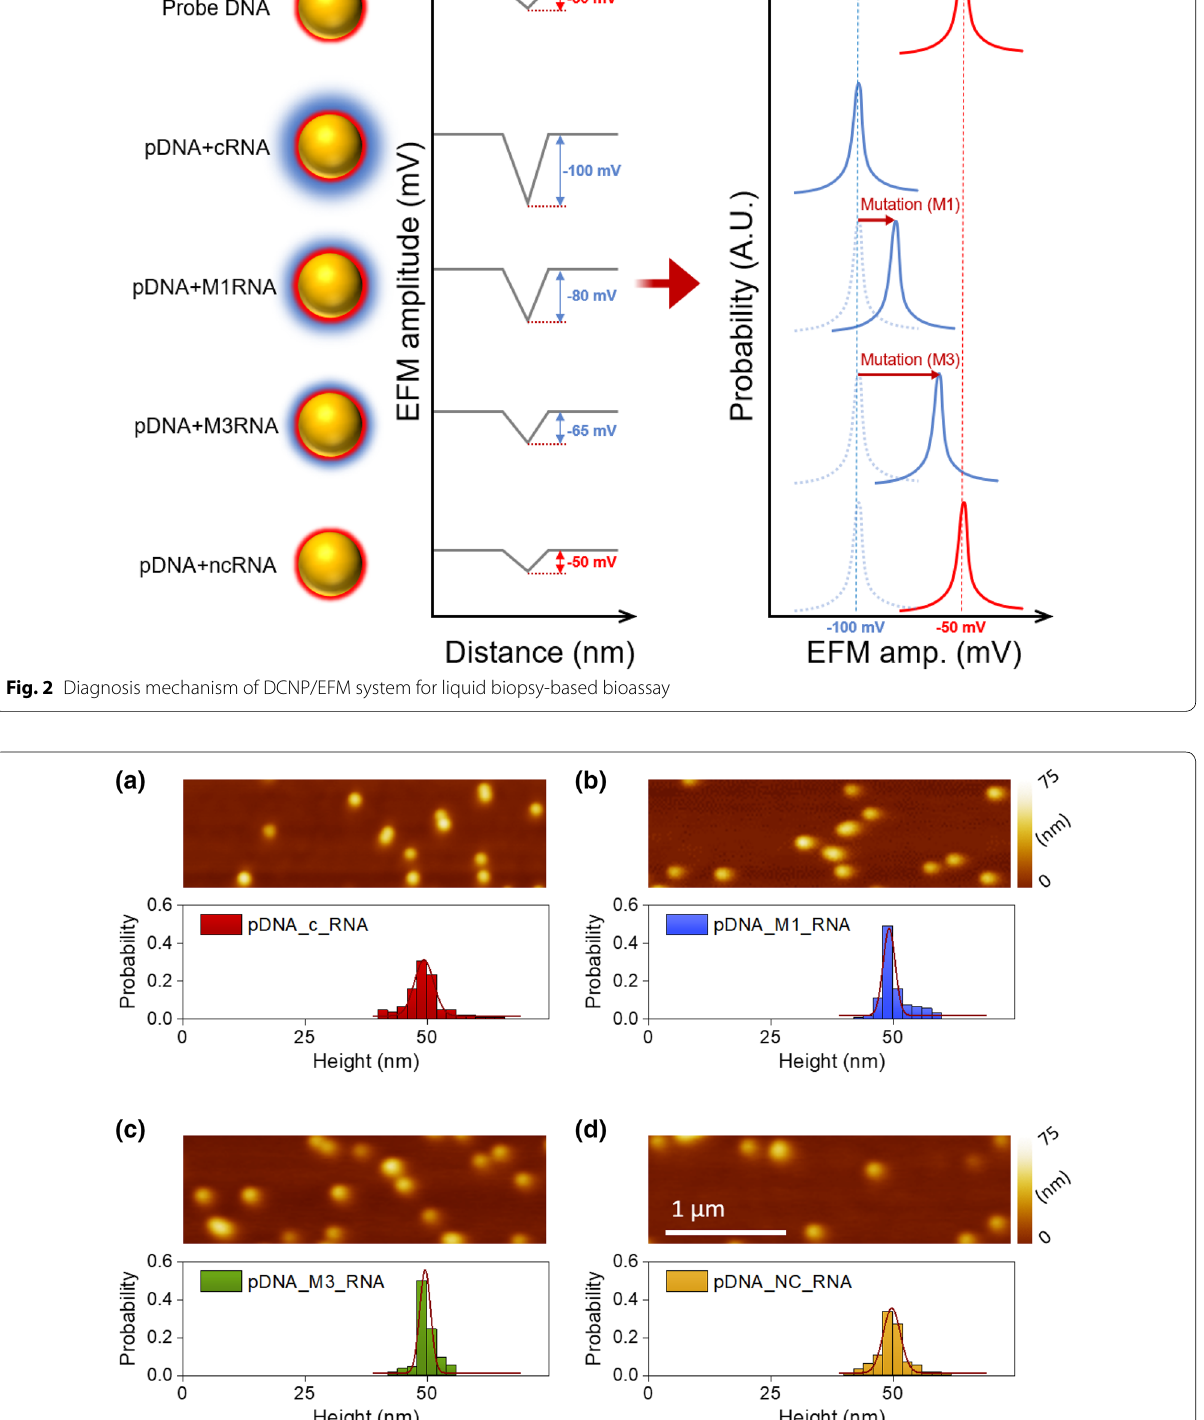
c_RNA, b pDNA M 1 _RNA, c pDNA + +